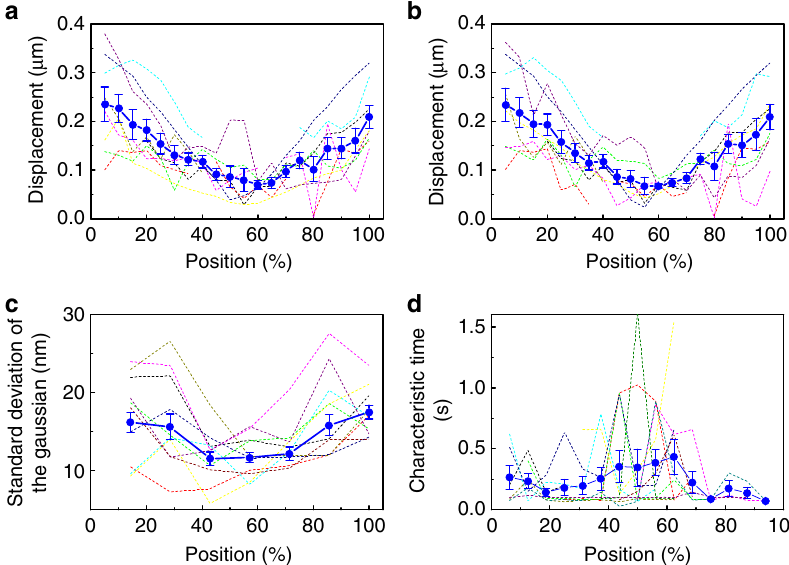
Fig. 5 Quantitative analysis of the motion of the entangled linear DNA molecules. a , b Mean position-dependent displacement of the Cy5-labelled lambda DNA occurring along the direction perpendicular to the contours during the time gap between the adjacent time frames in an aqueous solution containing 7 – 10 mg ml − 1 concentration of non-labelled lambda DNA. The displacements were calculated using a 3D contours and b 2D projected contours of the DNA molecules. The error bars show standard error of the means determined using 9 independent images of the DNA molecules. The dotted lines show the position-dependent displacement obtained from the 9 independent images of the DNA molecules. c Mean position-dependent standard deviation of the Gaussian obtained from the Cy5-labelled lambda DNA in an aqueous solution containing 7 – 10 mg ml − 1 concentration of non-labelled lambda DNA by the fi tting of the local intensity pro fi les of the reconstructed super-resolution images at each segment. The error bars show standard error of the means determined using 15 independent images of the DNA molecules. The dotted lines show the position-dependent standard deviation of the Gaussian obtained from the 15 independent images of the DNA molecules. d Mean position-dependent characteristic time obtained from the Cy5-labelled lambda DNA in an aqueous solution containing 7 – 10 mg ml − 1 concentration of non-labelled lambda DNA by the fi tting of the cumulative-area difference plots at each segment. The error bars show standard error of the means determined using 12 independent images of the DNA molecules. The dotted lines show the position-dependent characteristic time obtained from the 12 independent images of the DNA